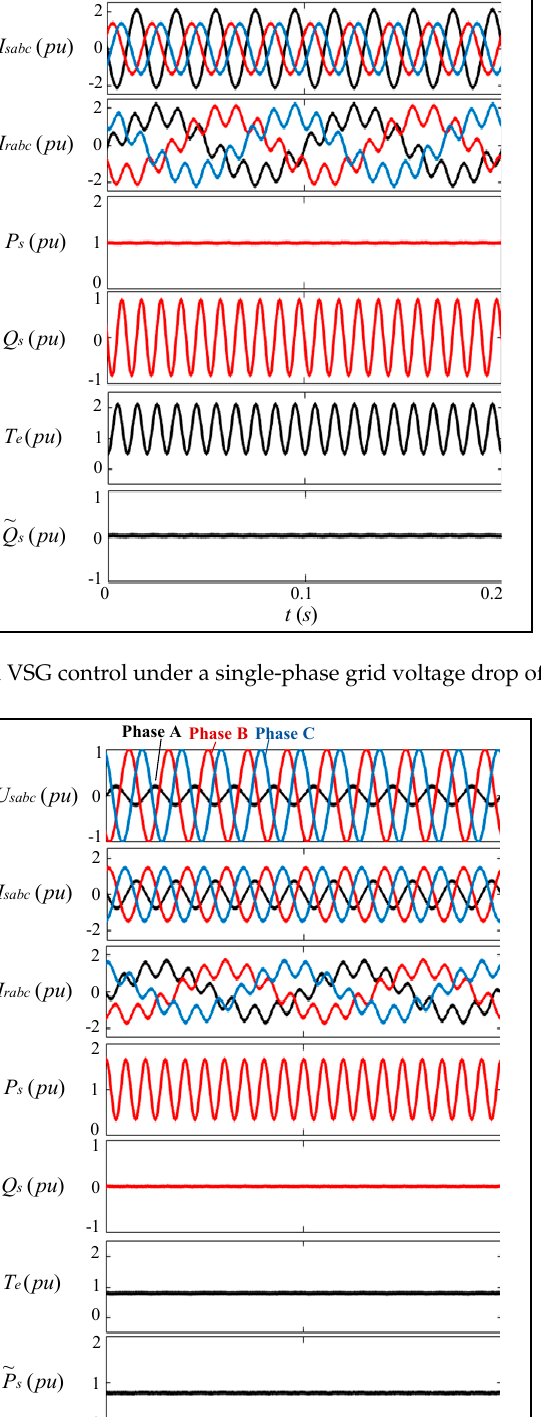
Figure 12. Proposed VSG control under a single-phase grid voltage drop of 80% (Target 2).